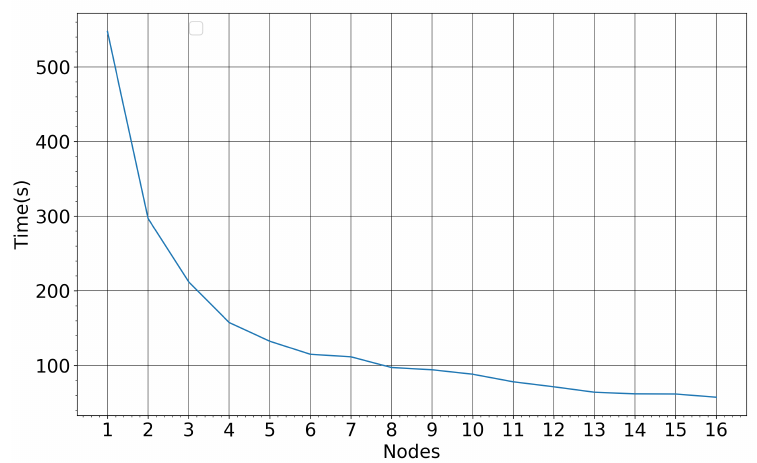
Figure 21. RF training time for a varying number of computing nodes—4 M entities, 36 CPUs and 512 GB memory.